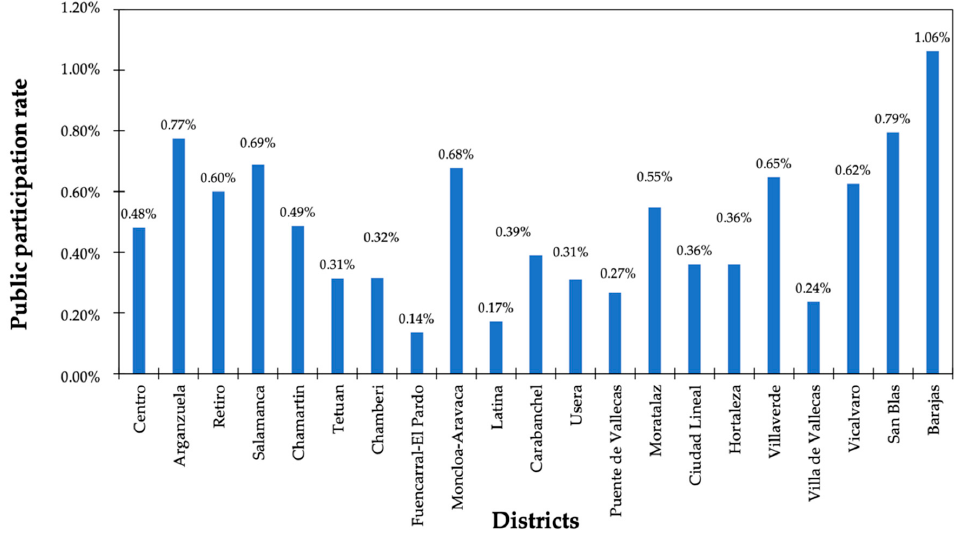
Figure 2. Public participation rate per district [26].